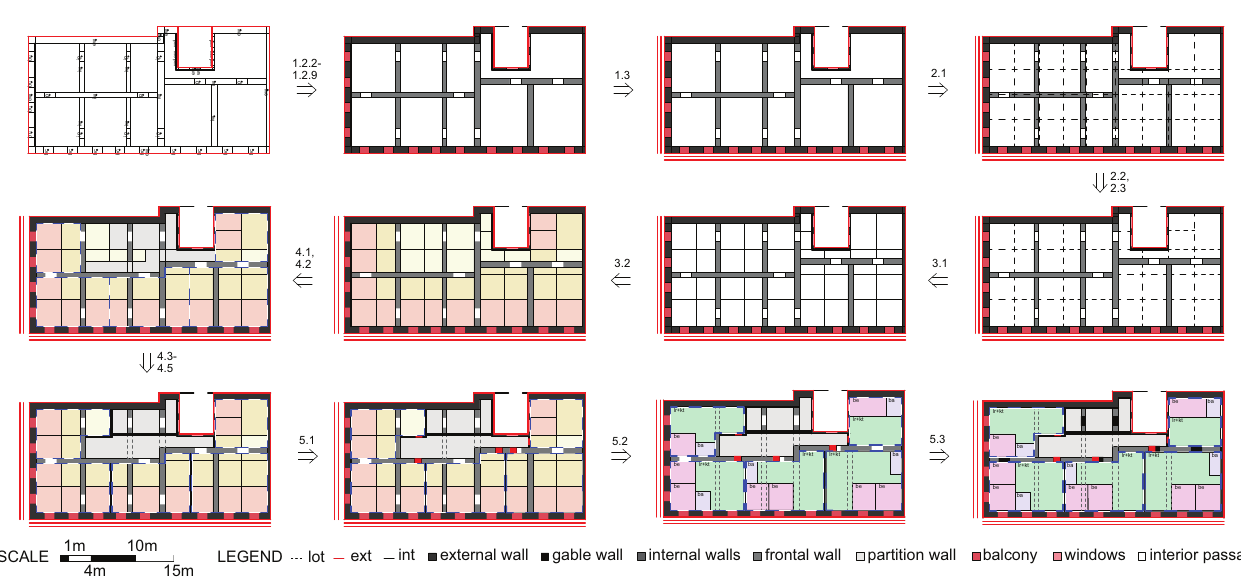
Figure 12. Derivation process for the case study building